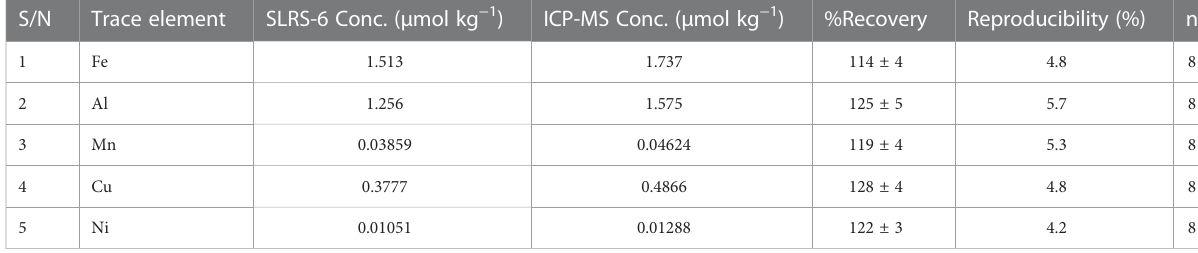
TABLE 2 Certi fi ed reference material concentration vs measured ICP-MS concentration showing percentage recovery. S/N